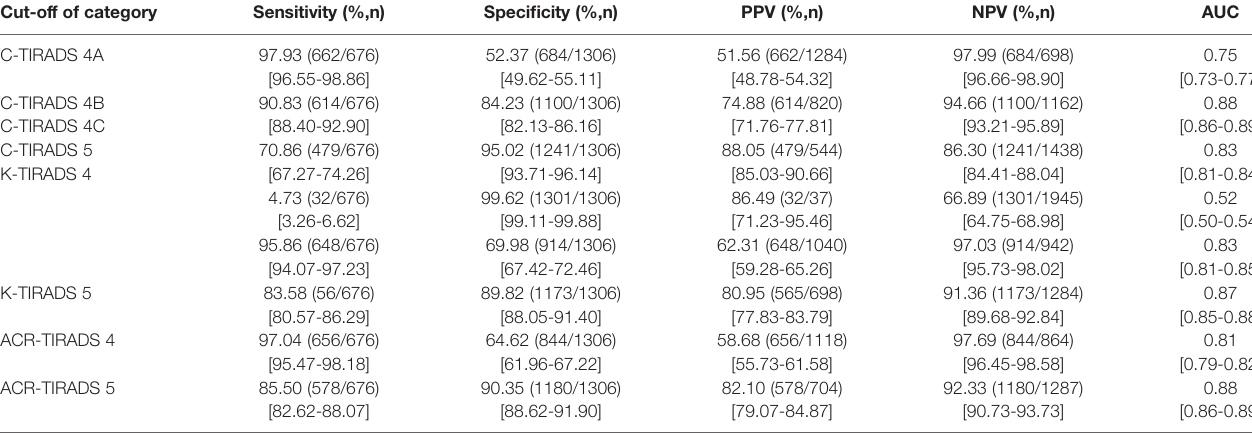
TABLE 4 | Diagnostic performances of three TI-RADSs by different cut-off of category. Cut-off of